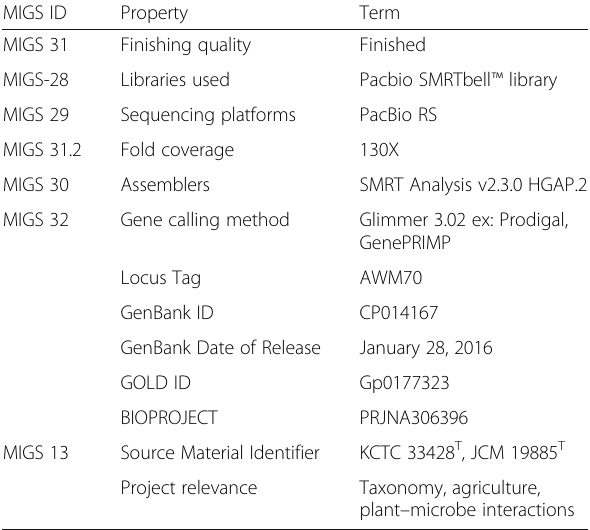
Table 2 Genome sequencing project information